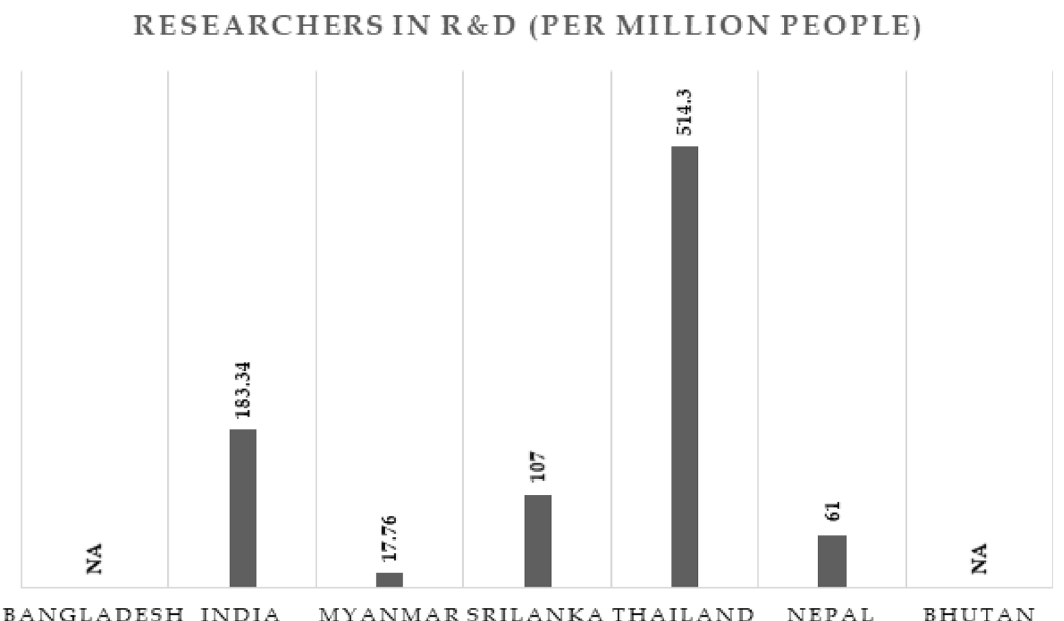
Figure 3. Researchers in Research and Development (per million people) in BIMSTEC countries